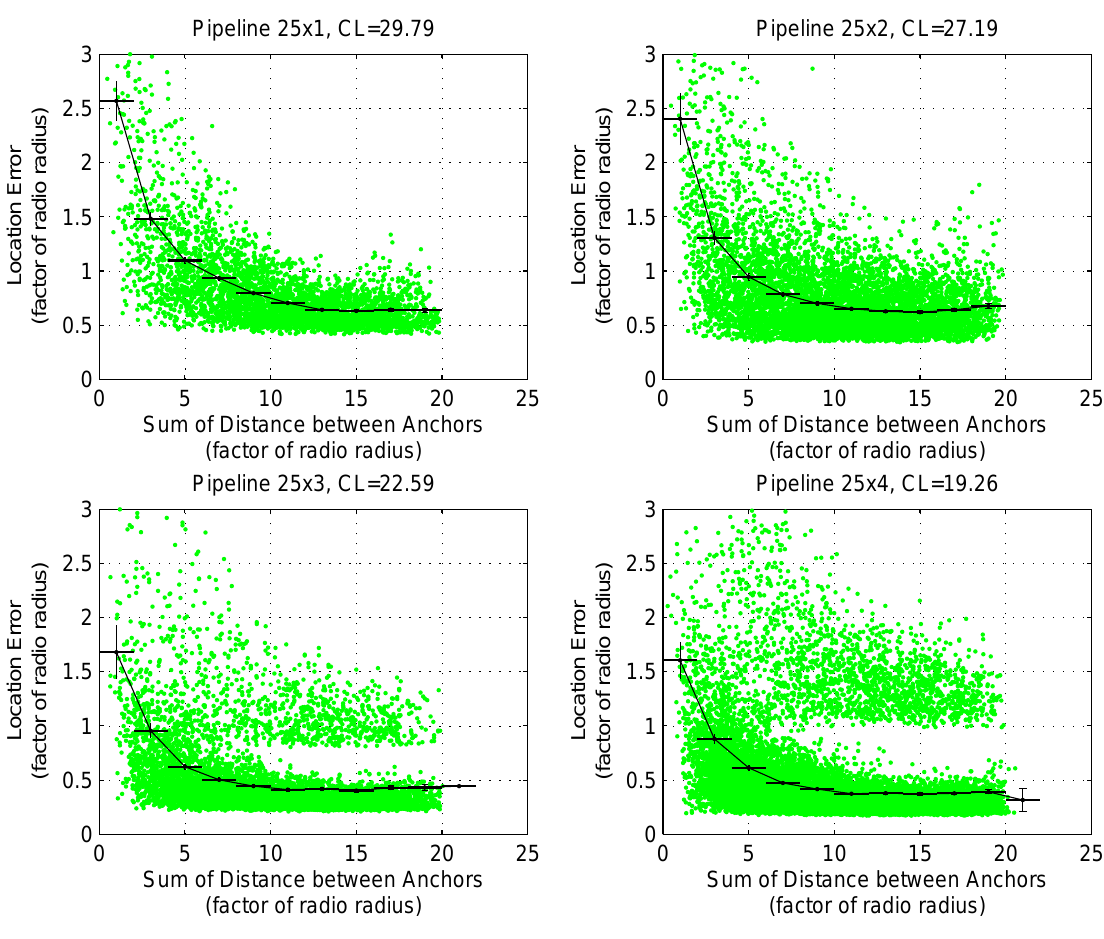
Figure 8. Sum of distance between anchors vs . mean localization error for random pipeline 25-by-1,2,3 and 4 unit networks with 200 nodes, 1,000 anchor sets each, and a radio range of 2.0